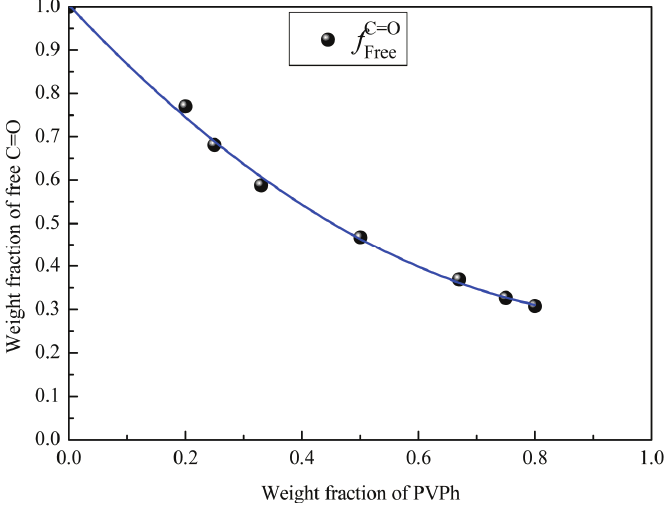
Figure 6. Evolution of free carbonyl fraction versus PVPh composition in